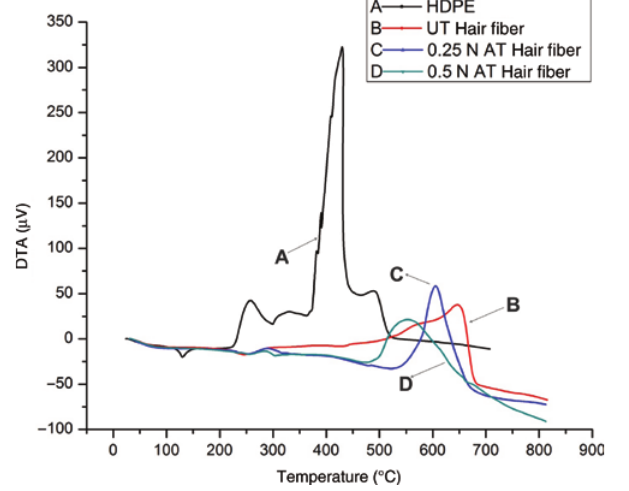
Figure 11: DTA thermograms of HDPE, UT, 0.25-N AT and 0.5-N AT HF. Table 2: DSC thermograms of different samples. Samples